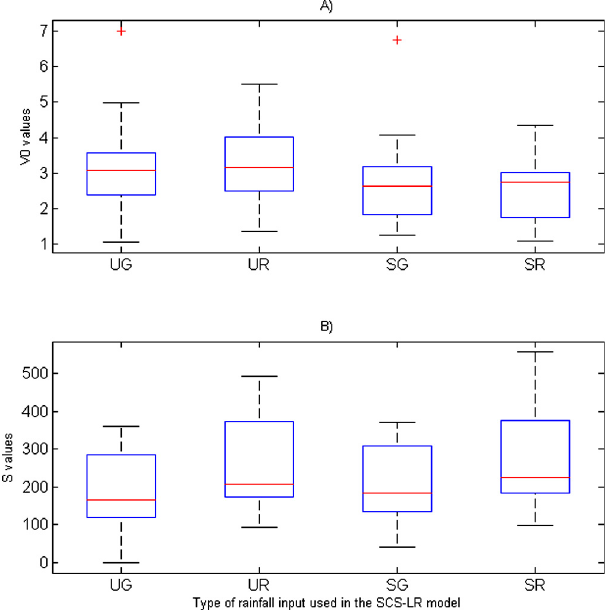
Fig. 6. Box-plot of V 0 (a) and S (b) values for each rainfall input in the rainfall-runoff model (the box has lines representing the lower quartile, median and upper quartile